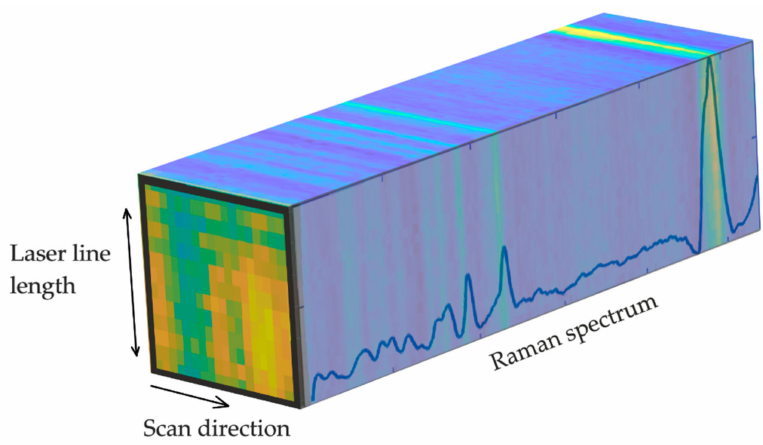
Figure 3. Hyperspectral cube containing Raman spectra collected across the laser line at each scan position. At Raman peaks of interest, images could be visualized providing the spatial distribution of molecular compounds. The LSRM image at the front of the hyperspectral cube shows the spatial distribution of functional molecular groups associated to the peak located at 2870 cm − 1 of pituitary gland